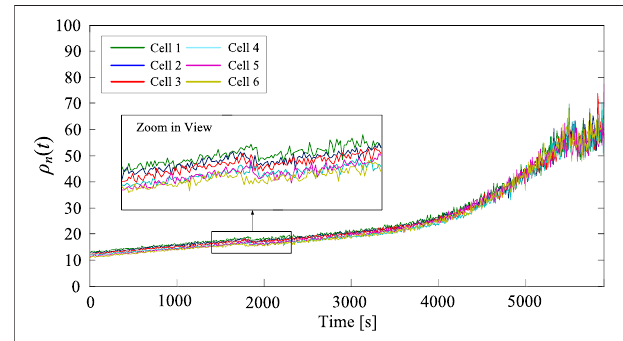
FIGURE 8 | Voltage deviation of six cells during the charging process with a dynamic acceleration coef fi cient adaptive mechanism.